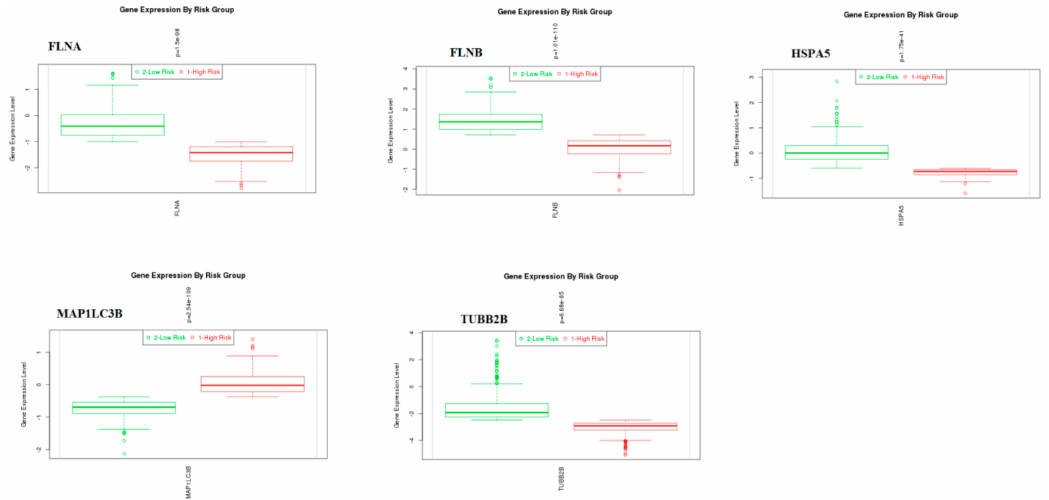
Figure 19. Box plots of hub genes ( BRCA1 , HIST1H3B , MAPK6 , NDRG1 , and PCNA ). Red—high-risk; Green—low-risk.